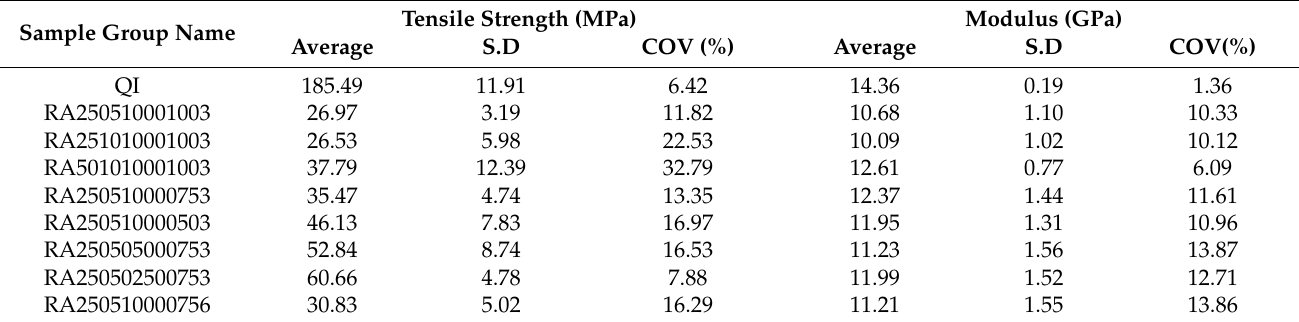
Figure 3. Tensile stress–strain curve of a recycled composite specimen. Table 2. Tensile properties of the manufactured panels.